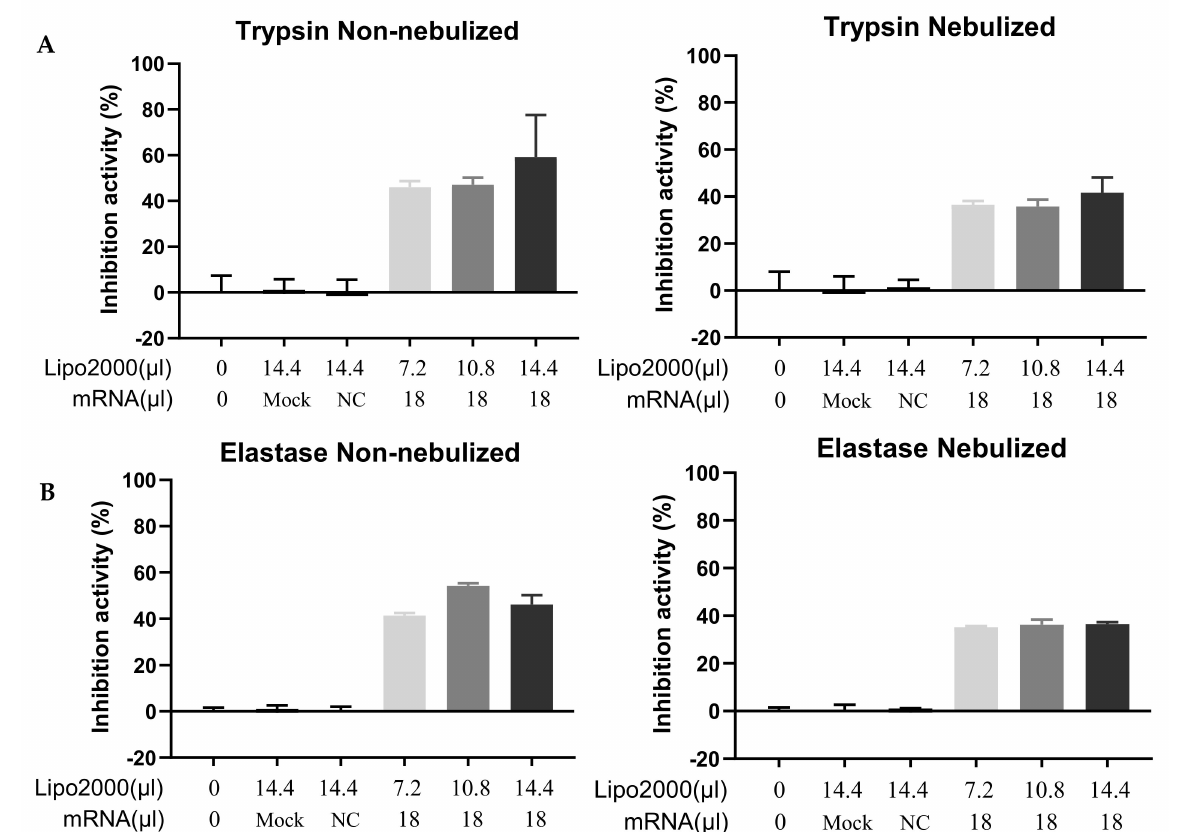
Figure 9. Functional assay of A1AT in supernatants of transfected cells. ( A ) Inhibition of trypsin activity by A1AT secreted from 16HBE cells transfected by non-nebulized or nebulized A1AT-mRNA/Lipofectamine2000 complexes, n = 8. ( B ) Inhibition of elastase activity by A1AT secreted from 16HBE cells transfected by non-nebulized or nebulized A1AT- mRNA lipoplexes, n = 4. For both assays, 7.2 µ L, 10.8 µ L or 14.4 µ L Lipofectamine2000 and 18 µ L IVT-mRNA-encoding A1AT (0.1 µ g/ µ L) were mixed to prepare complexes. A total of 14.4 µ L Lipofectamine2000-treated samples served as “Mock” controls. A total of 18 µ L MetLuc-mRNA was formulated with 14.4 µ L Lipofectamine2000, which was applied as negative control “NC”. “Lipo2000” represents Lipofectamine2000 and “mRNA” represents A1AT-mRNA (except Mock and NC). 16HBE cells were incubated with the A1AT-mRNA lipoplexes for 2 h and the medium was then replaced by a protein expression medium. The enzyme inhibition assay was performed 24 h after transfection. A total of 50 µ L cell culture supernatants was added to the reaction buffer, and the enzyme inhibition was assessed after the reaction. Untreated samples were used as blank controls and their absorbance were set as 100% (whose inhibition activity was 0%,